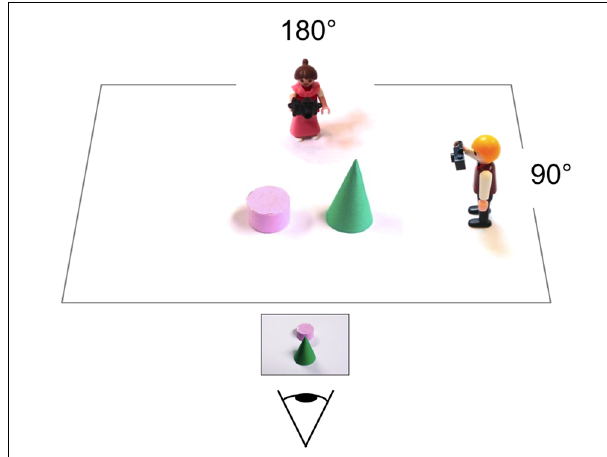
FIGURE 1 | Schematic of the layout and stimuli presented in the instruction phase. The symbolic eye indicates the children’s viewing